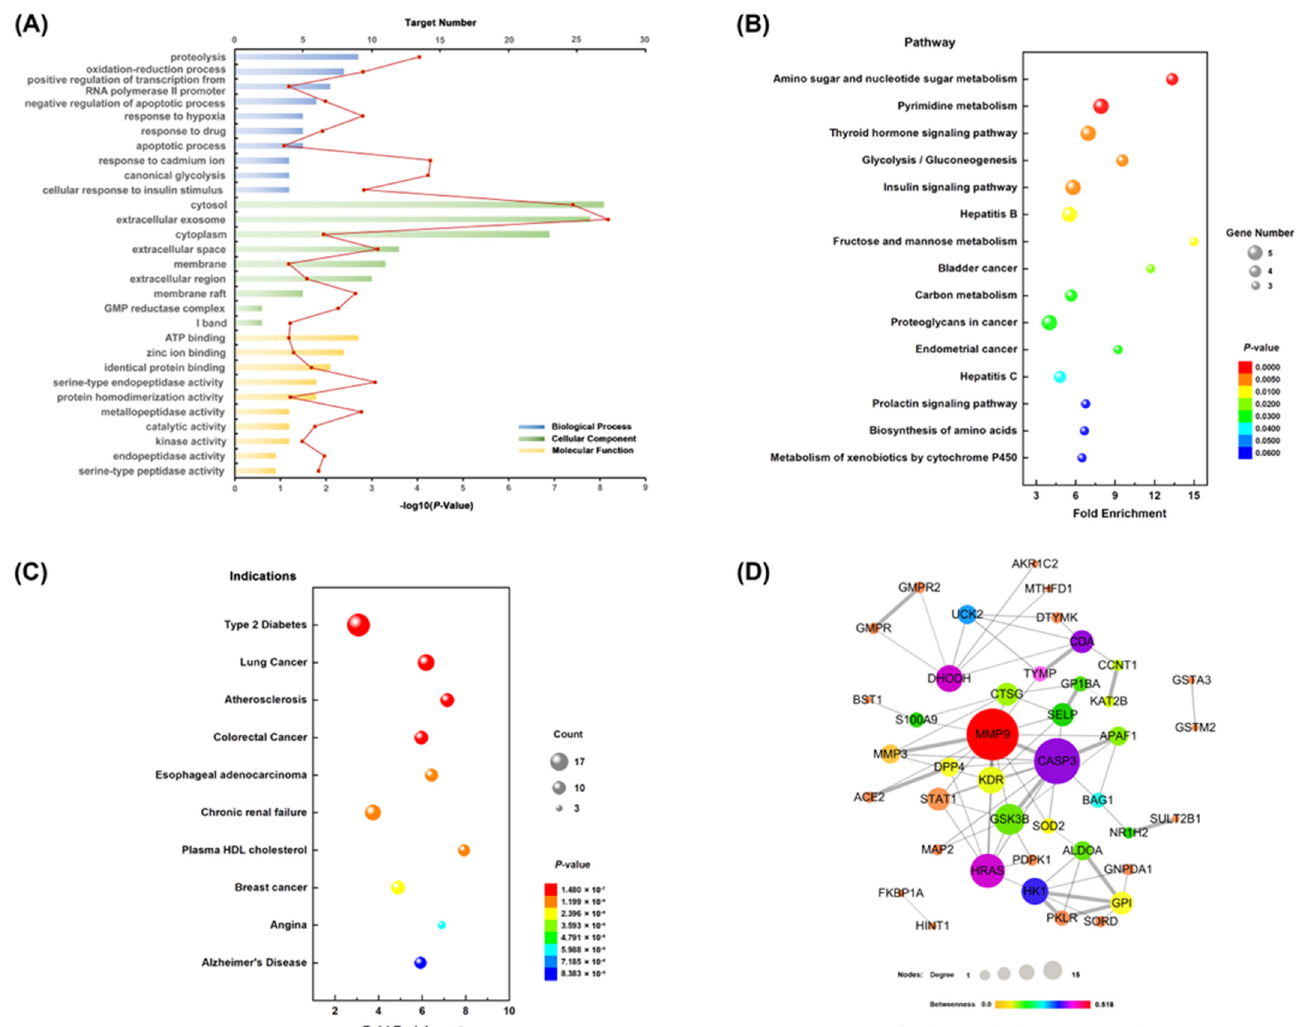
Figure 3. The network pharmacology analysis of secoatractylohexone A. ( A ) GO analysis of the candidate targets. Database shows the ten hub enriched items in the biological processes (BP), cell component (CC), and molecular function (MF). ( B ) The KEGG pathways of the candidate targets. ( C ) Related indications of the candidate targets. ( D ) The protein–protein interaction networks of the candidate targets.